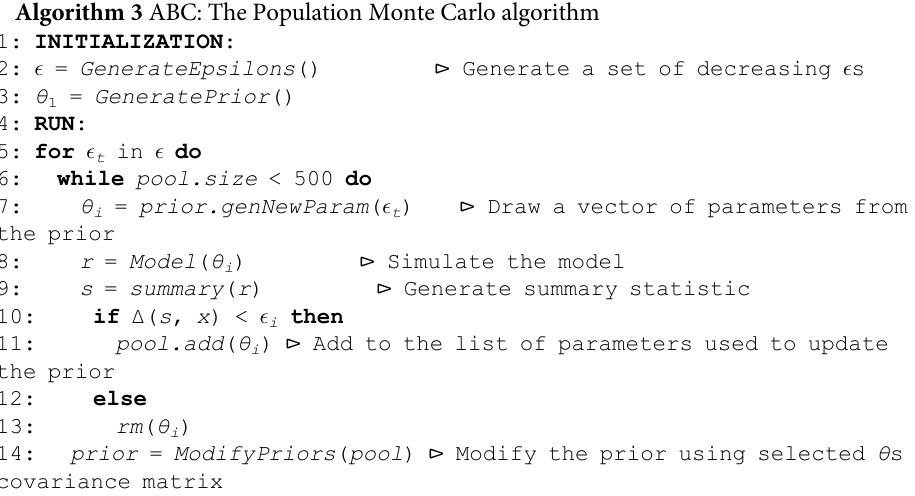
Algorithm 3 ABC: The Population Monte Carlo